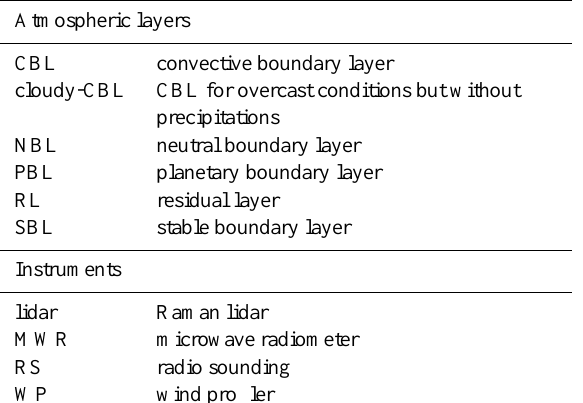
Table 1. List of